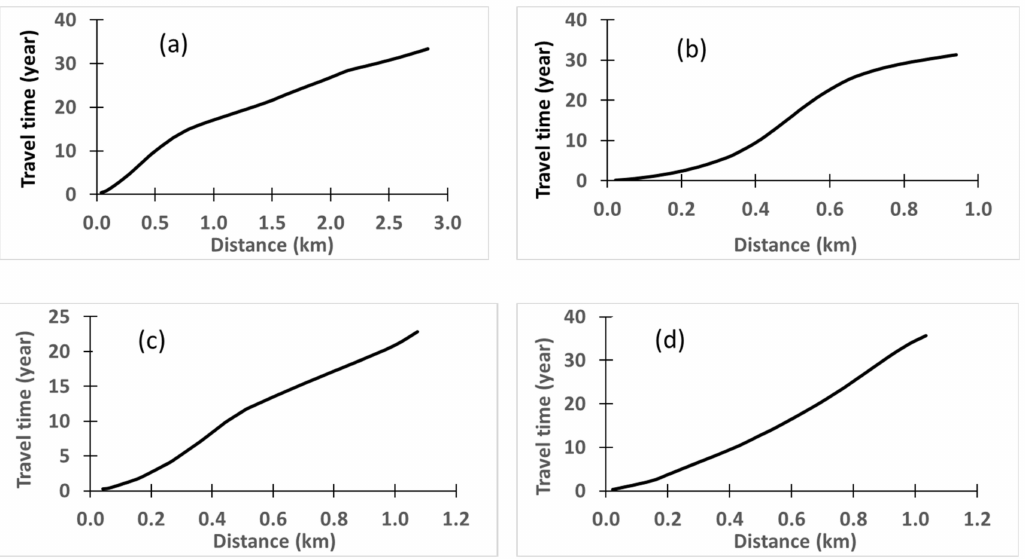
Figure 12. The distance-time relationships for the selected path lines of W1 (see Figure 11a). Figures ( a ), ( b ), ( c ), and ( d ) are for path lines 1a, 1b, 1c and 1d, respectively as in Figure 11a. All of that adds to the intricacy of the nitrate occurrence in the groundwater and its